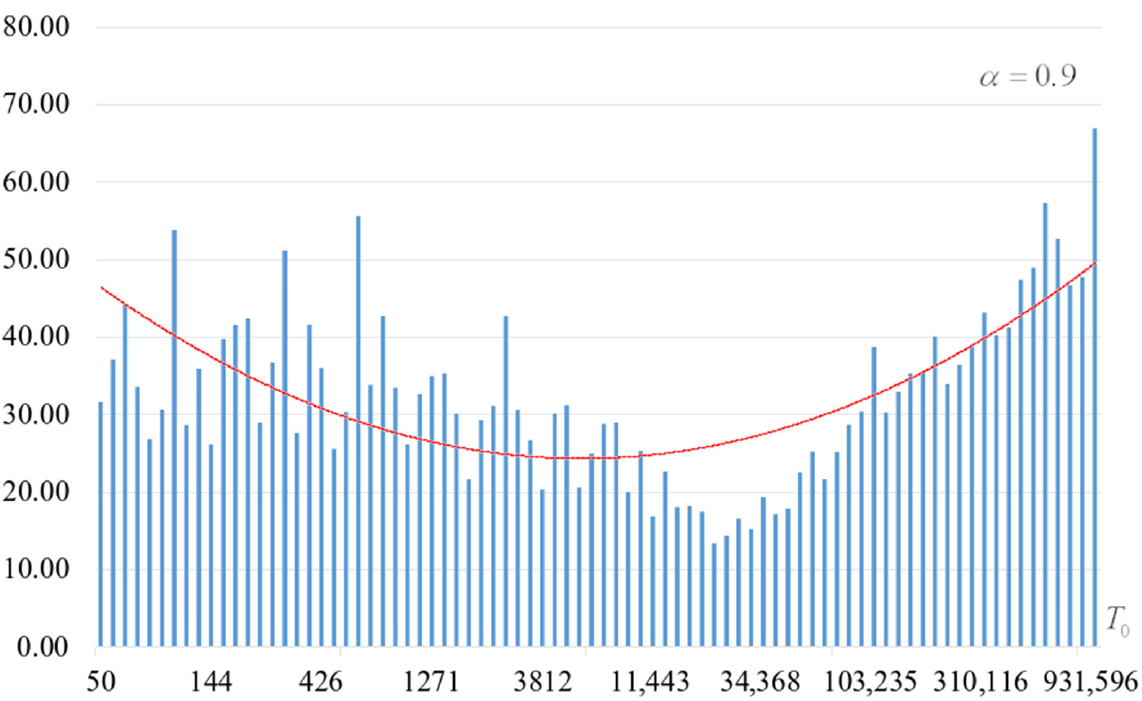
Figure 9. Average time (s) of target S-box formation at 𝛼 = 0.9 .